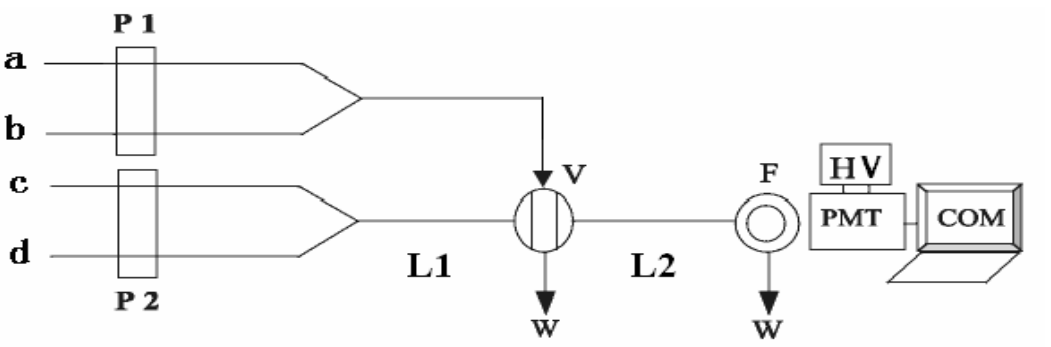
Figure 1. Schematic of the flow system for determination of hydroquinone and catechol. a, KMnO solution; b, β -cyclodextrin solution; c, sample solution; d, luminol solution; P1 and P2, peristaltic pumps 1 and 2; L2 450 mm length; V, eight-way injection valve; F, flow cell; PMT, photomultiplier tube; HV, high voltage (operated at -600 V); COM, computer; W, waste